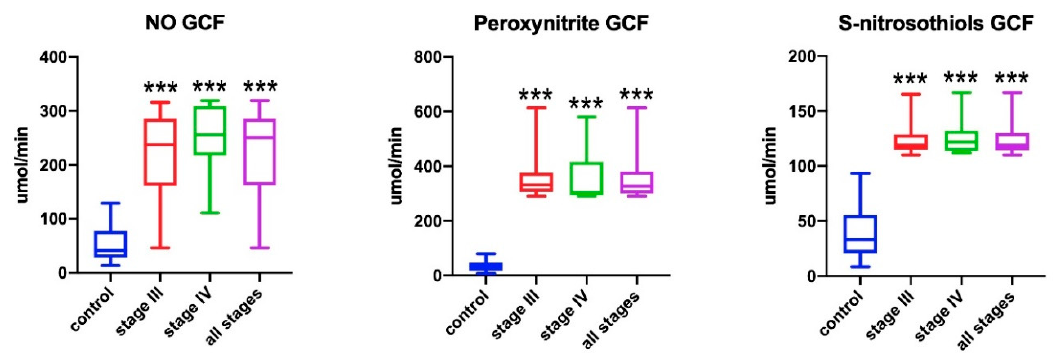
Figure 4. Concentrations of nitric oxide (NO), peroxynitrite, and S -nitrosothiols in gingival crevicular fluid (GCF) in all patient groups. *** p < 0.001 versus control group.